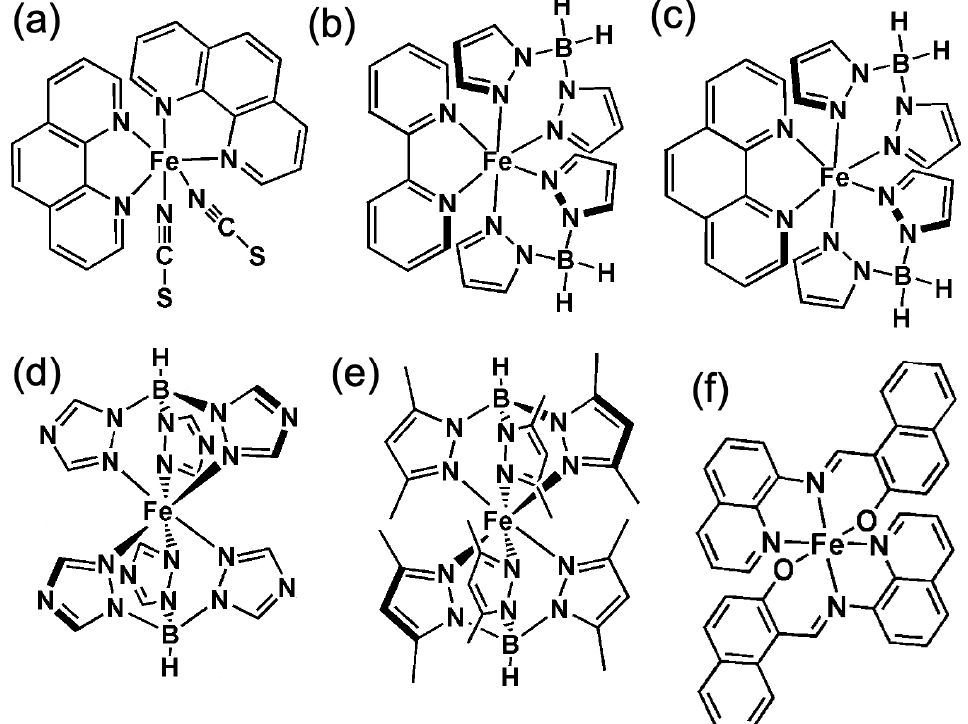
Figure 2. Some of the more popular spin crossover complexes that can be evaporated as molecular thin films. ( a ) [Fe(1,10- phenanthroline) 2 (NCS) 2 ], frequently written as Fe(phen) 2 (NCS) 2 . ( b ) [Fe{H 2 B(pz) 2 } 2 (bipy)] where (H 2 B(pz) 2 = bis(hydrido)bis(1 H -pyrazol-1-yl)borate, bipy = 2,2 ′ -bipyridine). ( c ) [Fe{H 2 B(pz) 2 } 2 phen] where again (H 2 B(pz) 2 = dihydrobis(1 H -pyrazol-1-yl)borate). ( d ) [Fe(HB(tz) 3 ) 2 ] (tz = 1,2,4-triazol-1-yl). ( e ) [Fe(HB(3,5-(CH 3 ) 2 (pz) 3 ) 2 ], pz = pyrazolyl]. ( f ) [Fe(qnal) 2 ] where qnal = quinoline-naphthaldehyde. Adapted with permission from ref. [8]. Copyright 2020 Wiley- VCH.